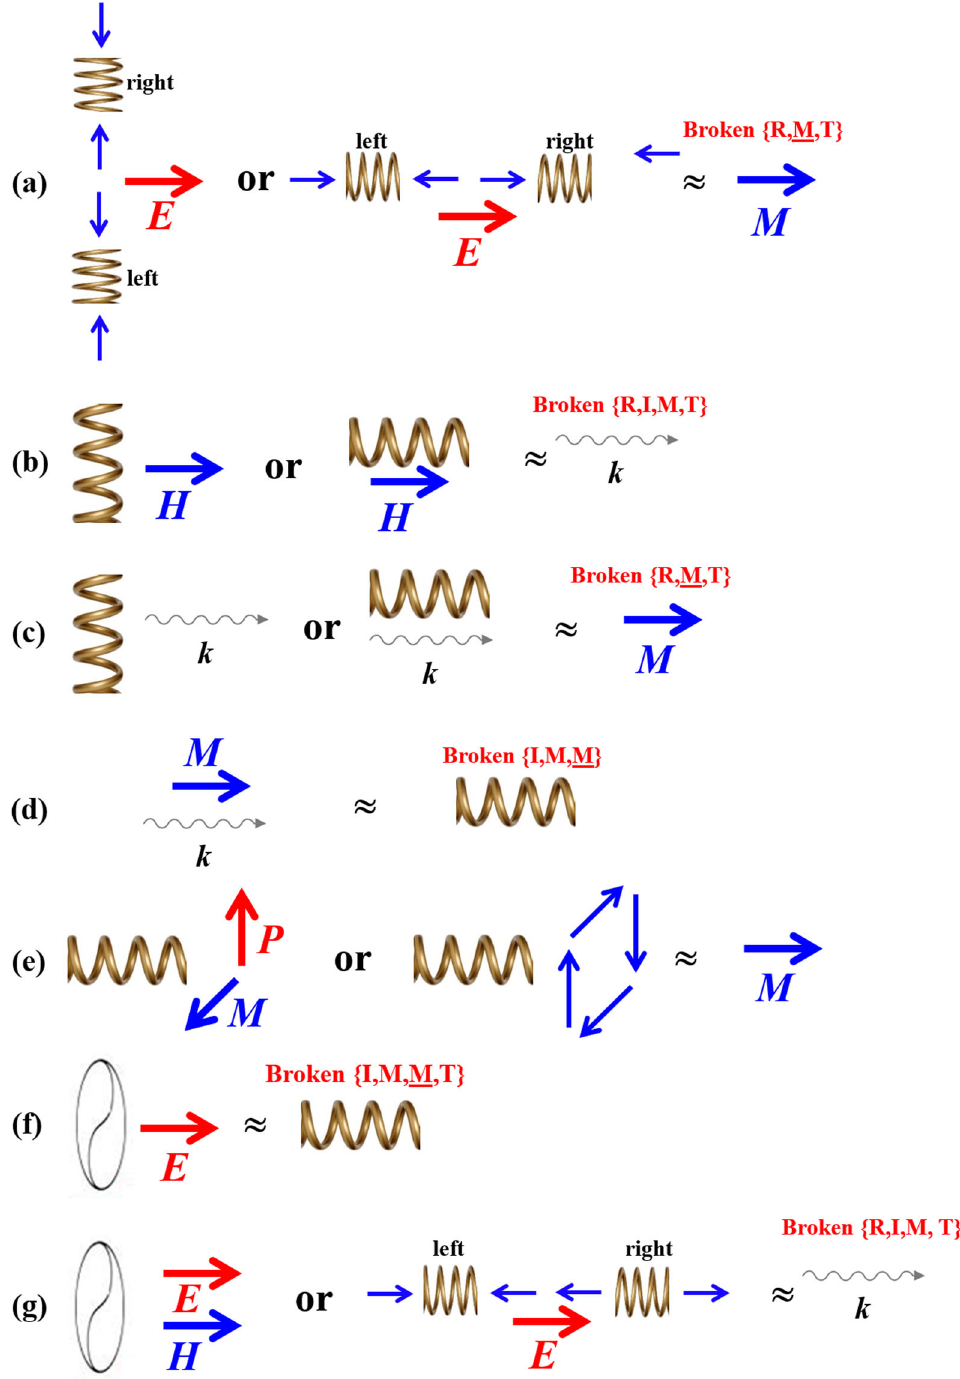
a a a 0 ; 0 (cid:3) C (cid:2) P 0 ; C (cid:3) P 0 (cid:2) 0 ; P 0 (cid:3) a Fig. 5 Various SOS relationships. The Yin-yang symbol represents ferro-rotation. a – g correspond to C 0 (cid:3) P (cid:2) a a a 0 (cid:2) C ; C (cid:3) P (cid:2) 0 ; P (cid:3) 0 (cid:3) C (cid:2) P (cid:3) D 0 (cid:2) P 0 , (cid:2) C , and a 0 ) is no longer allowed chiral, so exhibits a natural optical activity 24 , and should exhibit where the net magnetic moment M ( according to P (cid:3) P 0 (cid:2) D 0 . This is another premium example of non-reciprocal optical and also transport effects in the presence of magnetic fi elds, which need to be experimentally veri fi ed. Their how these permutable SOS relationships can be used to explain inverse effects in Fig. 5c, corresponding to (1), include magnetiza- and predict physical properties in real materials. tion induced by electric current in chiral materials and spin- Figure 5b corresponds to (6), which explains longitudinal and also polarized tunneling in chiral materials. The magnetization induced transverse magnetochiral effects, i.e., non-reciprocal electronic by electric current in chiral Te single crystals has been reported in a transport or optical effects in chiral materials in the presence of Faraday-type optical experiment as well as a direct magnetization external magnetic fi elds 23 . Note that a twisted graphene bilayer is